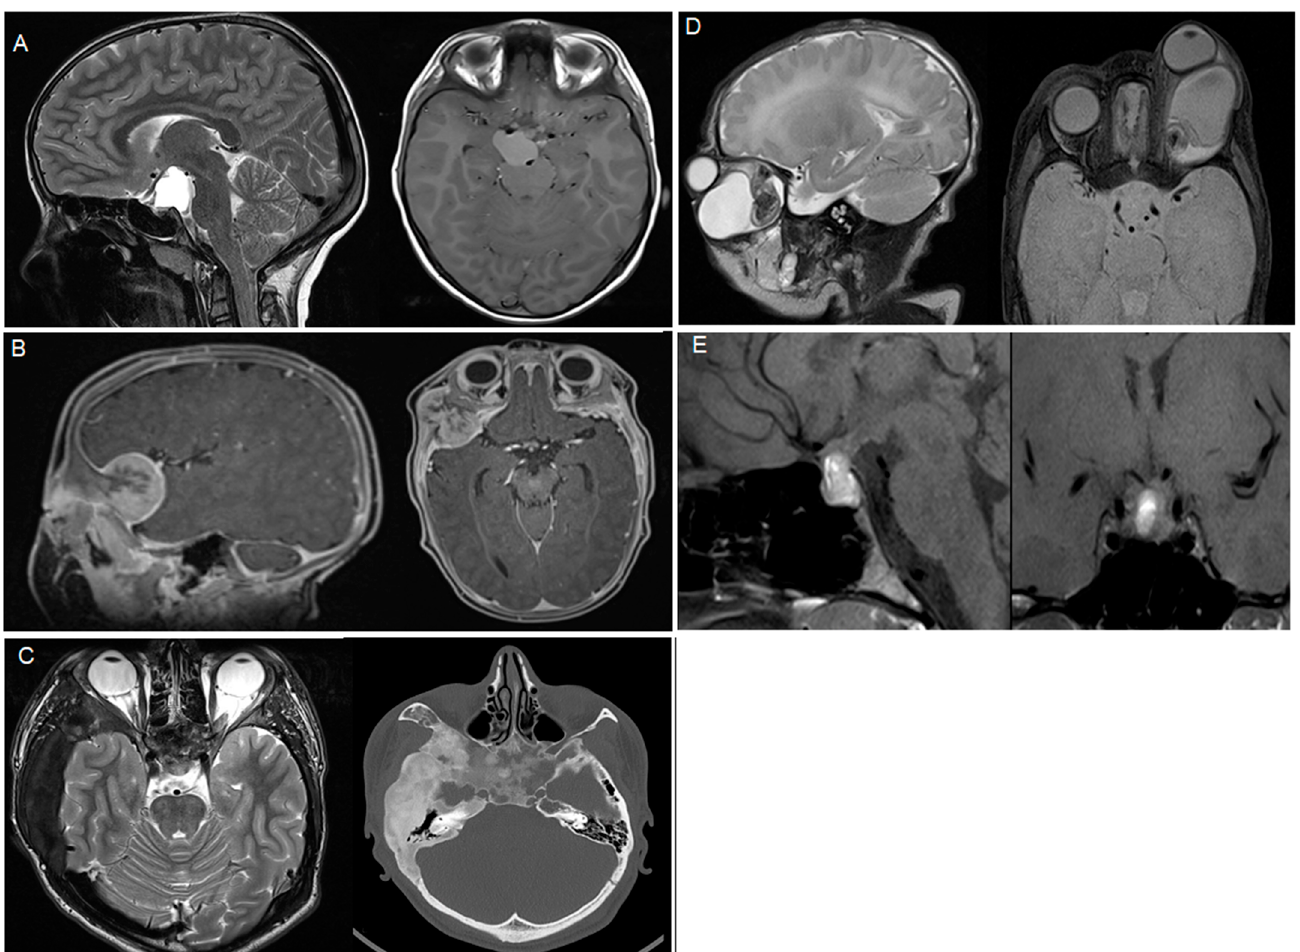
Figure 1. Representative imaging of the included pathologies, ( A ) adamantinomatous cranio- pharyngioma, ( B ) melanotic neuroectodermal tumor, ( C ) fibrous dysplasia, ( D ) teratoma, ( E ) pro- lactinoma.